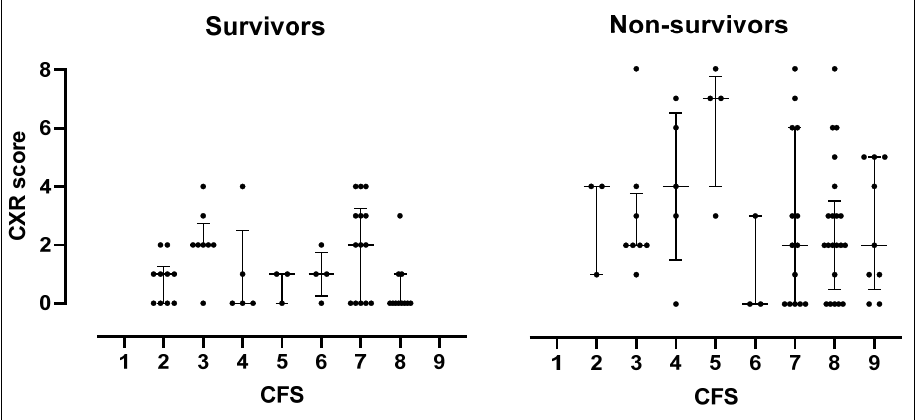
Figure 2. Column plot of the RX score in each CFS group and by death.